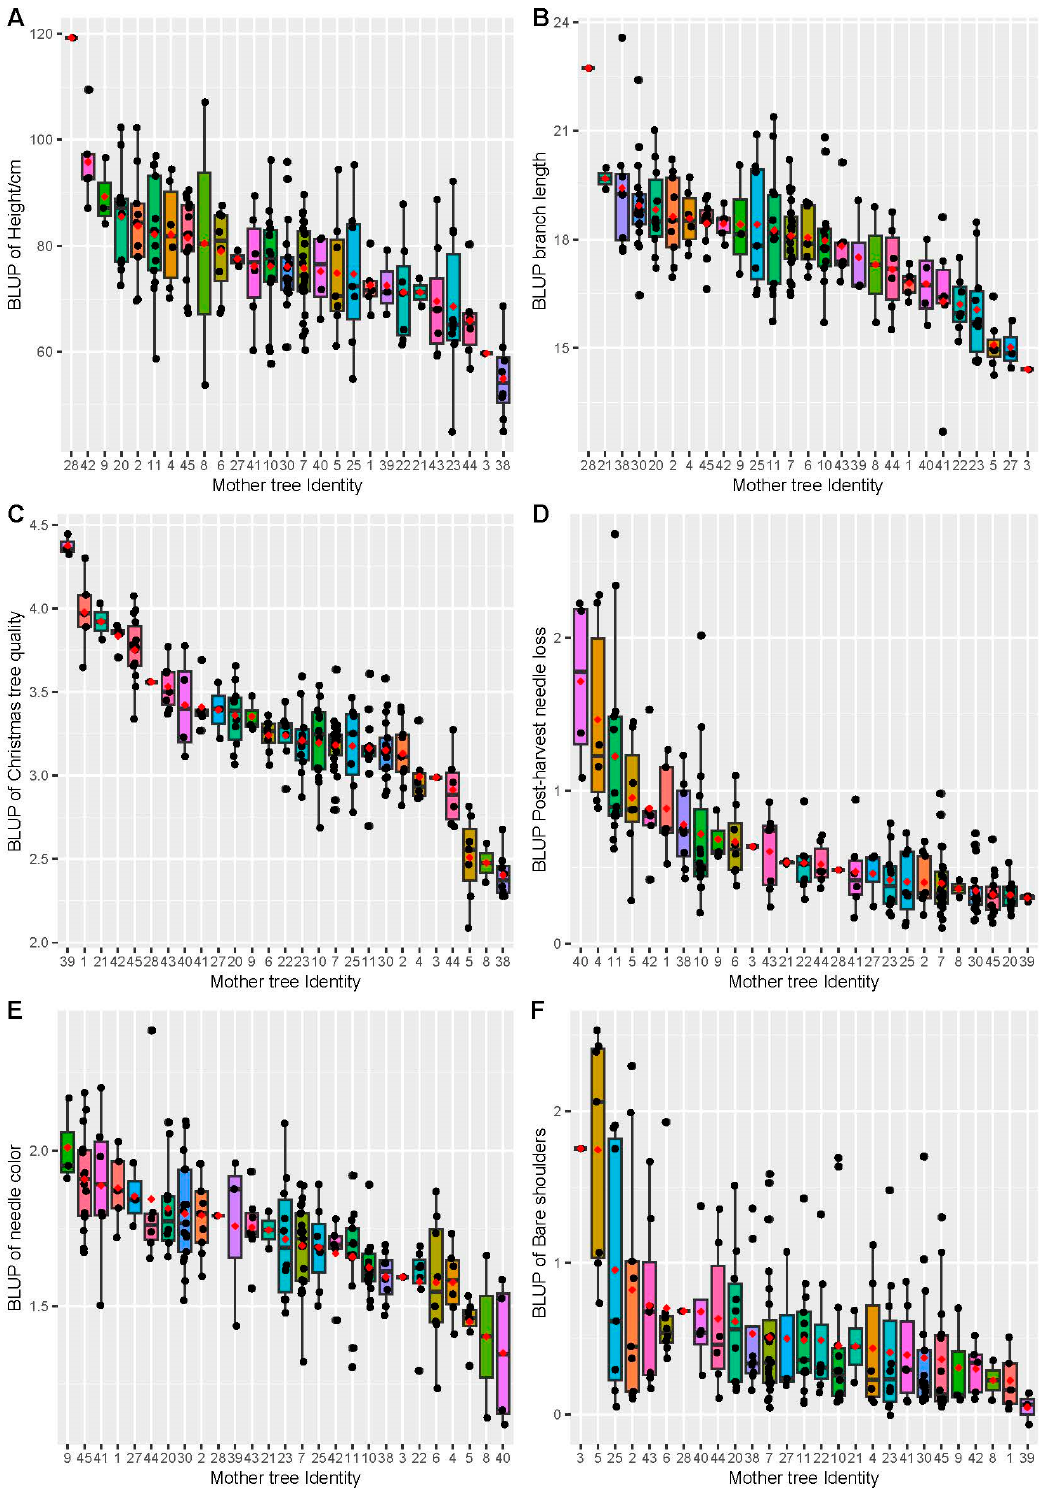
Figure 5. Boxplot of best linear unbiased predictions (BLUPs) of 27 half-sib families for studied traits; the red dot in each box indicates the mean BLUP of each half-sib family; black dots around each box indicate clone values of clones from each half-sib family. Traits: ( A ) height, ( B ) branch length; ( C ) Christmas tree quality; ( D ) post-harvest needle loss; ( E ) needle color; and ( F ) needle disorder bare shoulders.